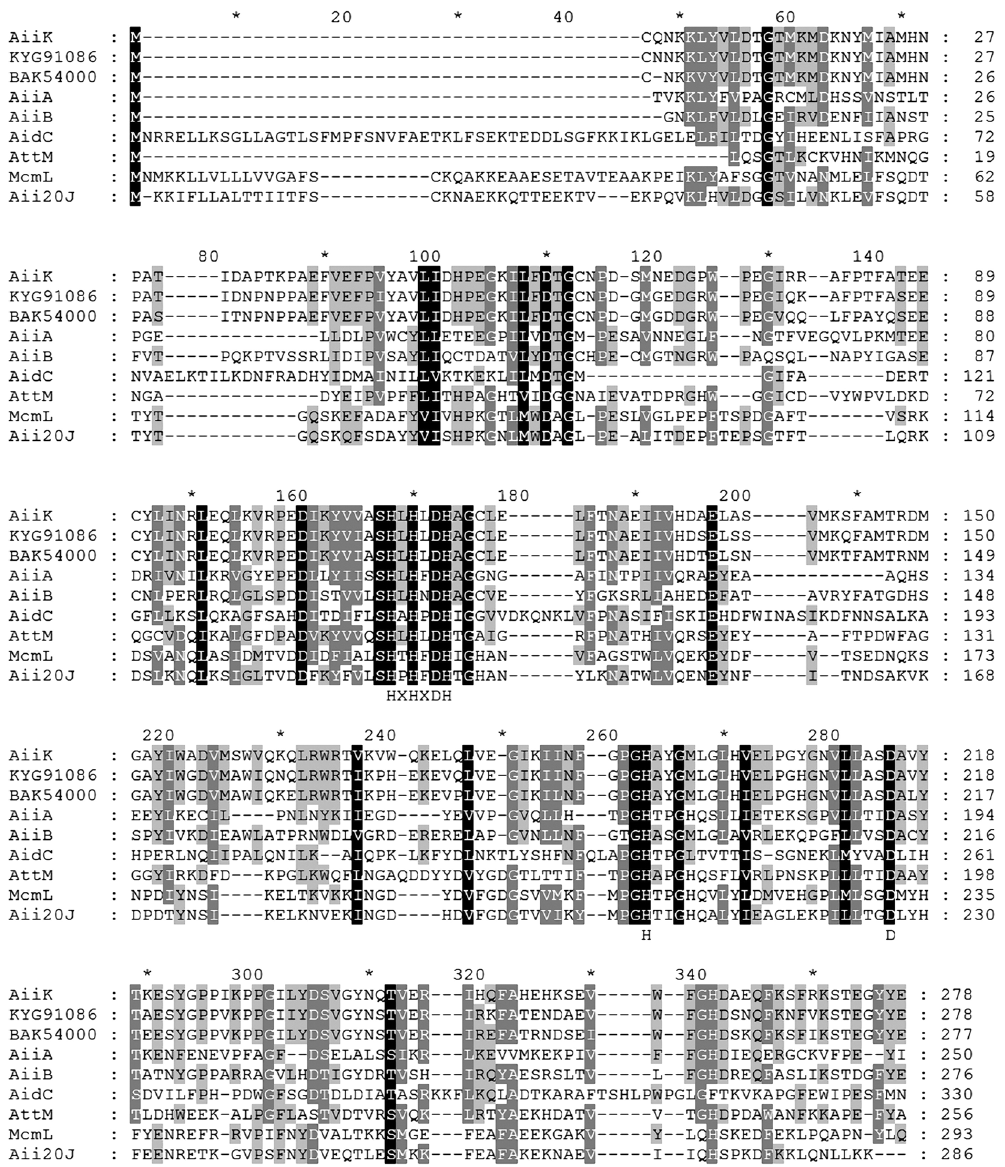
Figure 8. Multiple sequence alignment of amino acid sequences of AiiK (WP_029500404) and other representative AHL lactonases. The amino acid sequences were retrieved from NCBI or UniProt database. Sequence alignment was assesses by using of the MEGA 4.0 and GeneDoc. AiiK homologue from Bacillus sp. KCTC 13219 (KYG91086) and Solibacillus silvestris (BAK54000) showed the highest score and second highest score by BLAST searching in NCBI database. Other amino acid sequences of AHL lactonase are the first enzyme AiiA from Bacillus sp. strain 240B1 (AAF62398), AiiB (NP 396590) and AttM (AAD43990) from Agrobacterium fabrum str. C58, AidC from Chryseobacterium sp. strain StRB126 (BAM28988), MomL from Muricauda olearia (AIY30473), and Aii20J (AKN24544) from Tenacibaculum sp. 20J. These lactonases share a conserved domain (HXHXDH-H-D) essential for AHLs